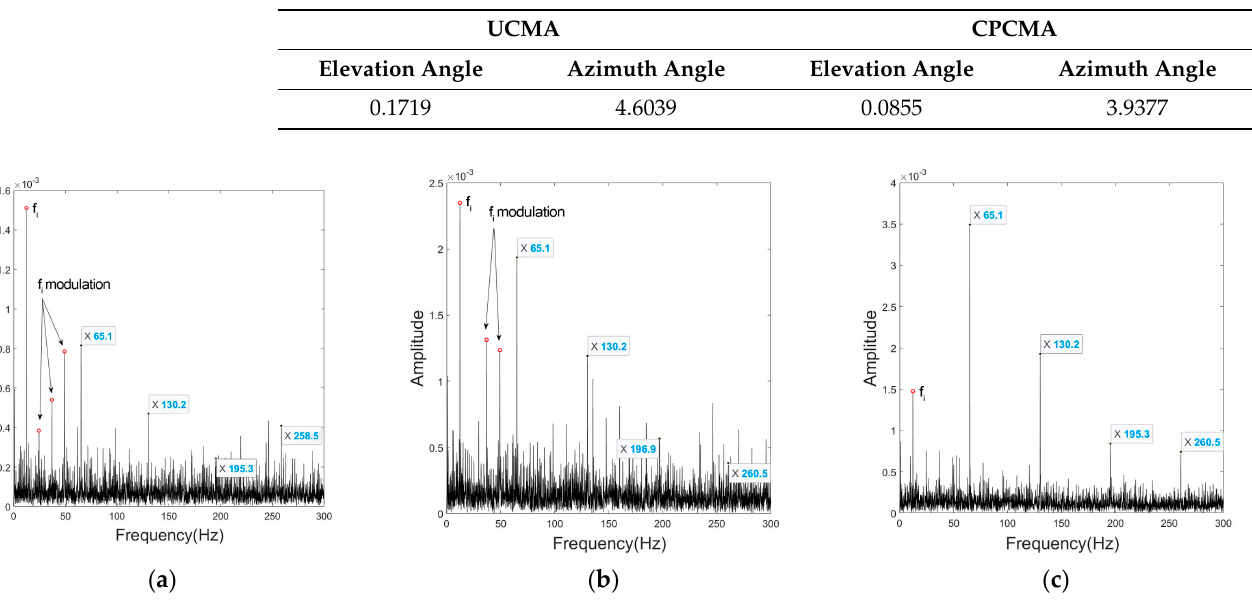
Table 20. RMSE in inner race defect located by both arrays at 725 rpm.